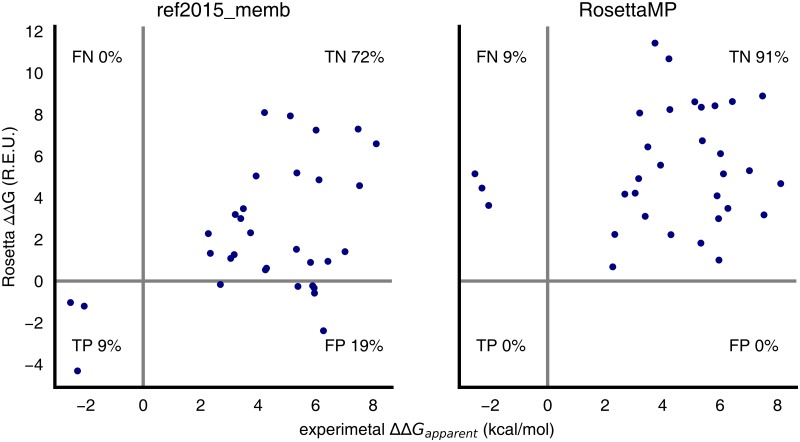
Predicted versus experimental ΔΔGbinding values of single-point mutations in glycophorin A.The structure of every point mutant was predicted ab initio, and the median ΔΔGbinding relative to the wild type sequence is reported. Only point mutations that exhibited |ΔΔGbinding| ≥ 2 kcal/mol in the experiment were analysed. TP, TN, FP, and FN—true positive, true negative, false positive, and false negative, respectively.